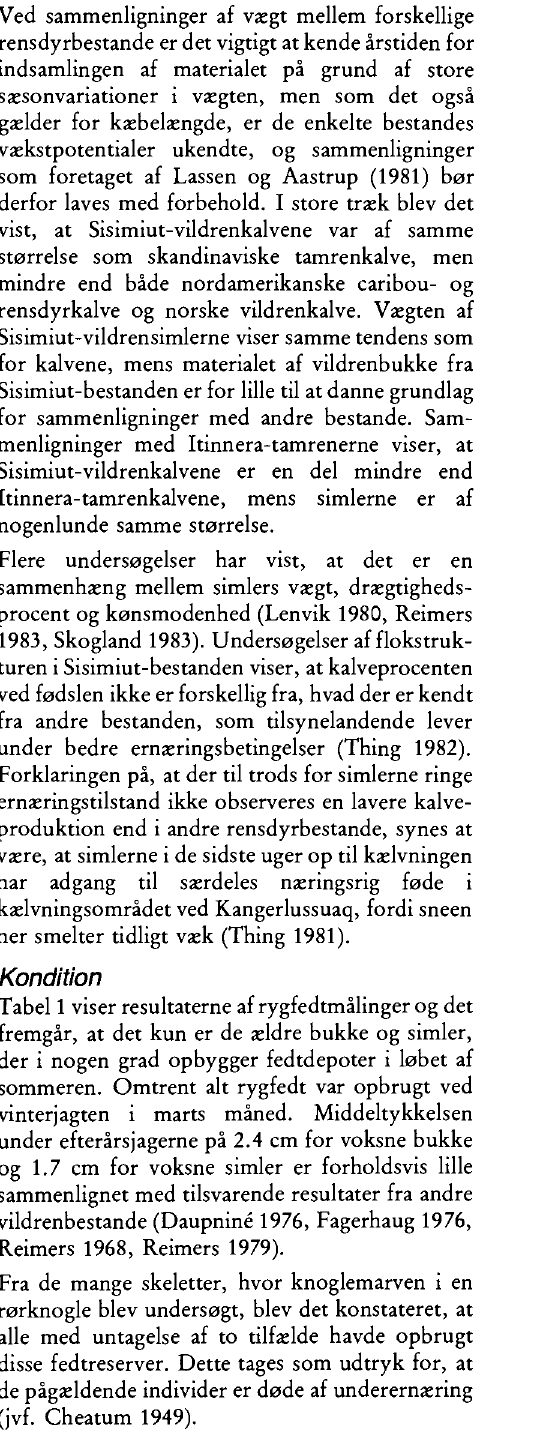
Fig. 3. Gennemsnitlig slagtevægt i forhold til køn og alder hos vildreen fra Sisimiut-bestanden. • efterår, • vinter. Søjler angiver 2 x middelfejl. Fig. 3. Mean carcass weight in relation to sex and age of caribou from the Sisimiut Populations. 9 autumn, • winter. Bars indicate 2 x standard